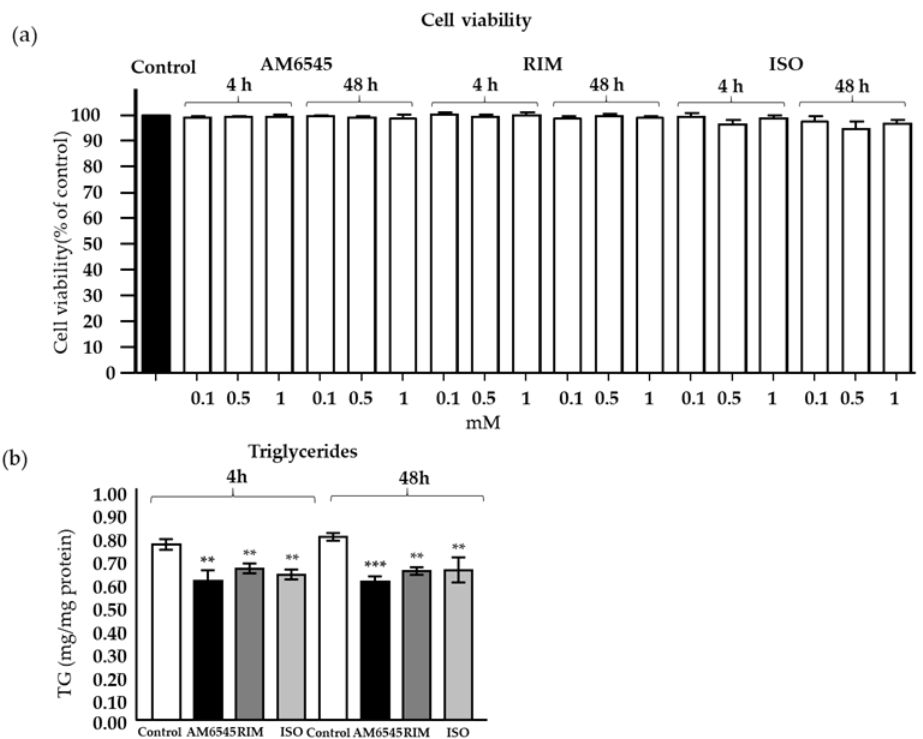
Figure 1. ( a ) Cell viability in 3T3-L1-differentiated cells were treated with AM6545, rimonabant (RIM), and isoproterenol (ISO) at 4 and 48 h. ( b ) Cell triglyceride (TG) content after 4 and 48 h of treatment. Data on graphs are presented as mean ± Standard Error of Mean SEM of 4 independent rounds of the cells; ** p < 0.01 vs. control *** p < 0.001 vs. control.